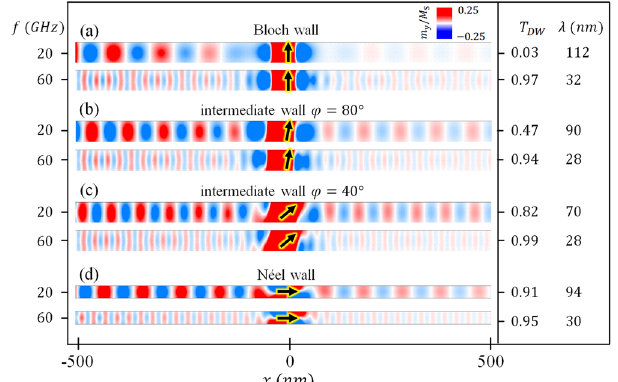
Figure 2. Top view of the 20 and 60 GHz SW transmission through different types of DW indicated in Fig. 1(b). Snapshots of the y component of the magnetization are shown. The black arrow indicate the orientation at the center of the DW. The transmission ratio and the respective SW wavelengths are shown on the